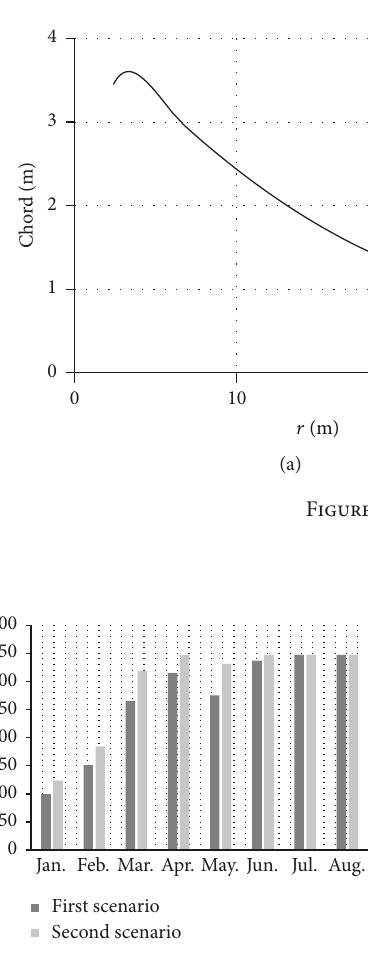
Figure 6: Monthly power generation from the HAWT.